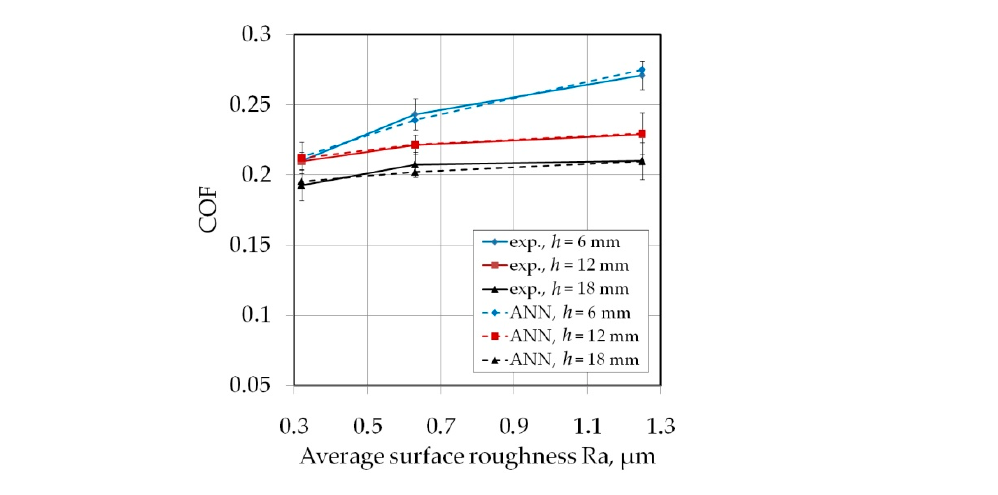
Figure 25. The effect of average surface roughness Ra of countersamples on the value of COF (orientation 0°, sample width w = 20 mm, dry friction conditions).